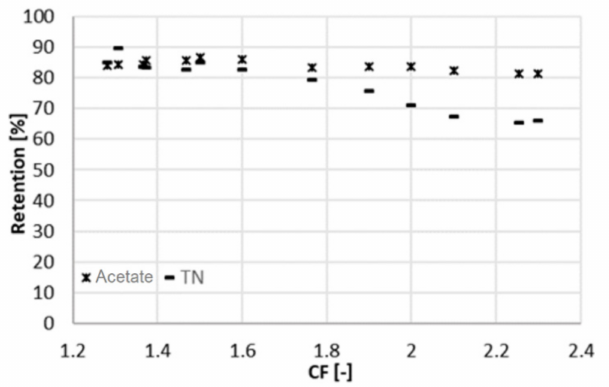
Figure 4. Retention of acetic acid and ammonium (measured as TN) at different CF (22 bar). The concentration of acetic acid in the permeate increases with CF. This was a con- sequence of the higher concentration in the feed, which led to a higher osmotic pressure (Figure 2). A higher concentration in the feed resulted in a higher flux of solute through the membrane. A higher osmotic pressure indicated at the same time a decline of the effective pressure, i.e., the driving force for water flux through the membrane. Thus, the concentration of acetic acid in the permeate turned out to be greater, and the permeability decreased with the concentration factor, since the effective applied pressure